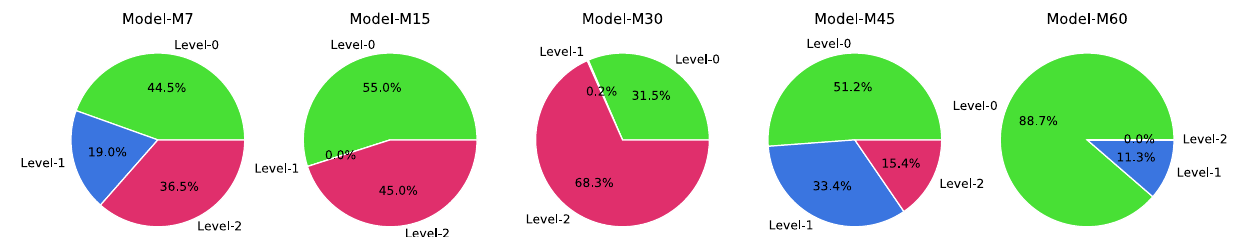
Figure 10. The figure represents the ratio of the actions performed by each agent. Agent M15 and M30 mostly instruct level-0 and level-2 restrictions. Agent M7 and M45 charge all types of rules. Whereas, agent M60 mainly engage level-0 and level-1 restrictions.